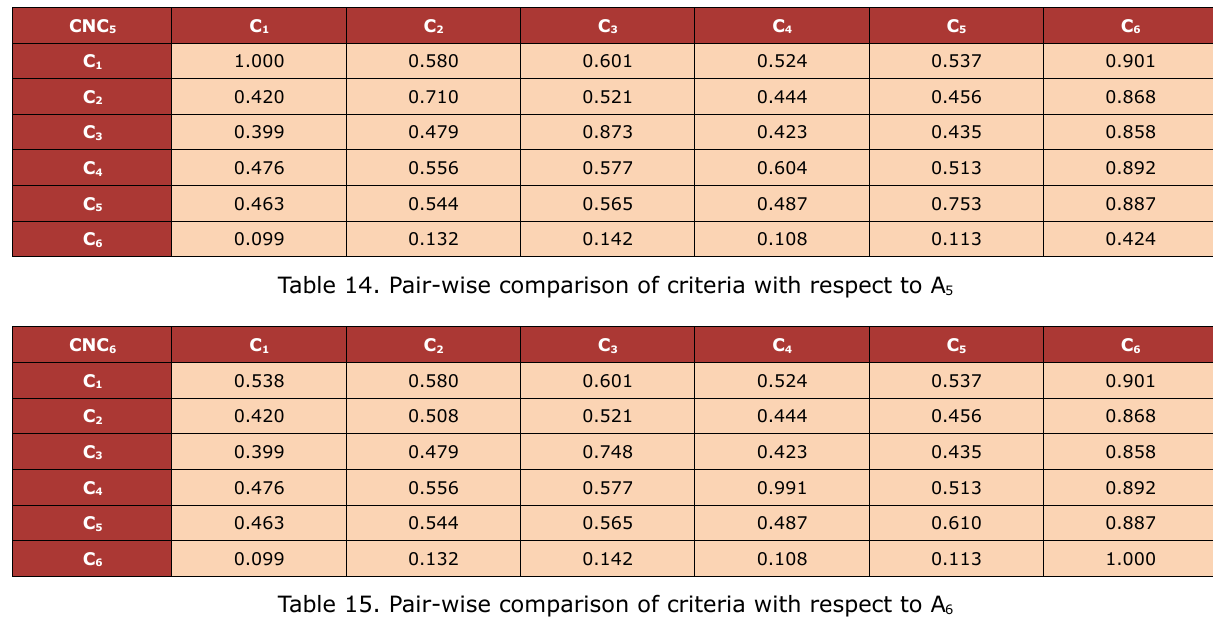
Table 13. Pair-wise comparison of criteria with respect to A 4